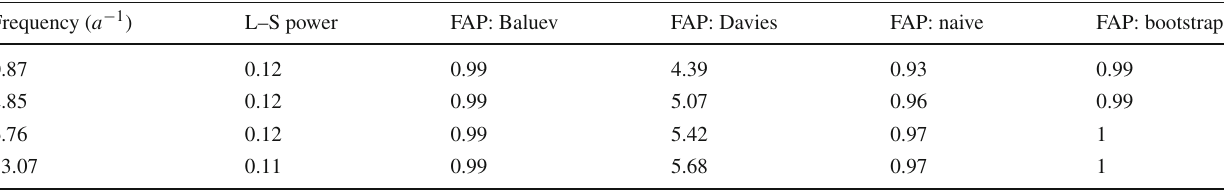
Table 2 PTB L–S powers along with the FAP for the top four most significant peaks (with power > 0 . 1) computed using the same meth- ods as in Table 1. We find that none of the FAPs are less than 0.1, and